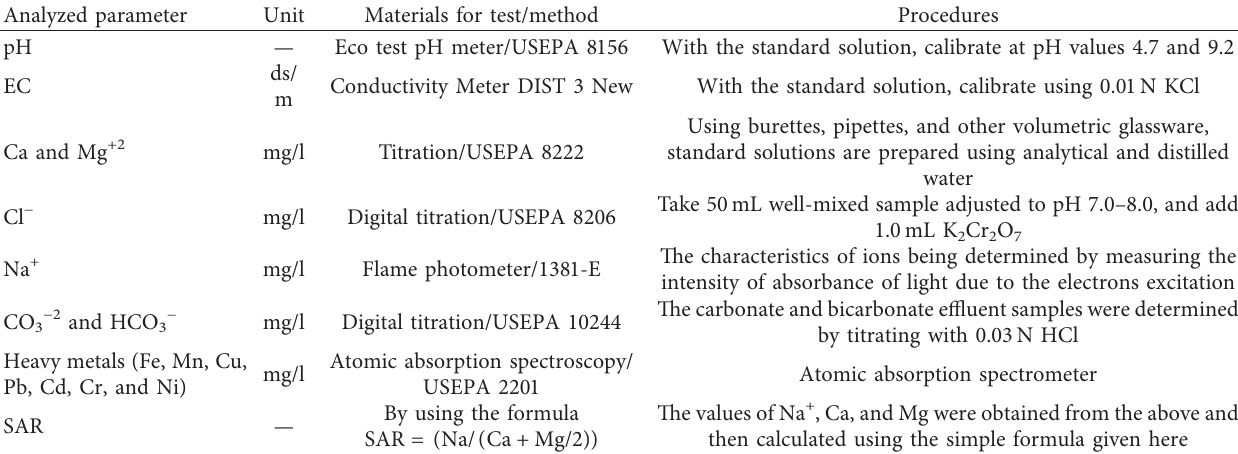
Table 1: Methods for physicochemical analysis.